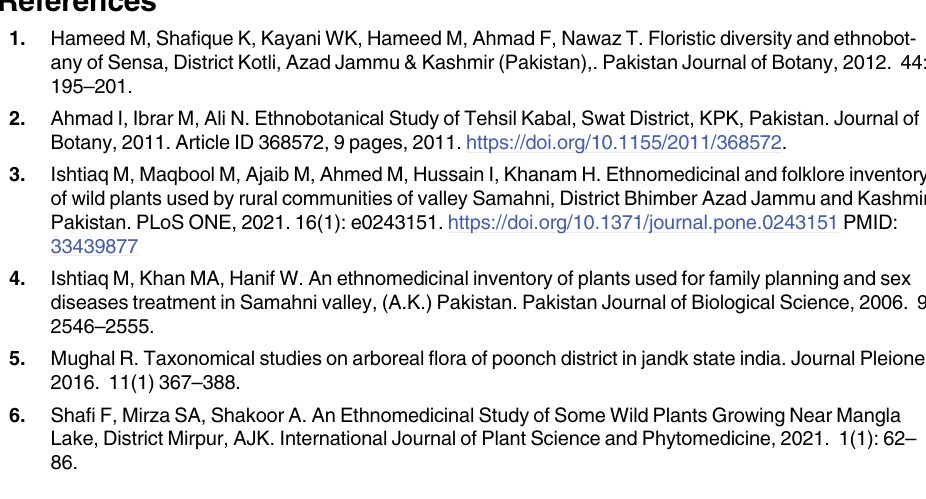
strict rules at governmental level to conserve of most common EB plant species from degrada- tion. There is need to expand the Prime ministers ‘billion’s tree tsunami’ project by involve- ment of youth in its propagation, cultivation and protection. This will lead towards ‘green revolution’ and make the environment eco-friendly with least pollution impacts as well as timely raining for good agriculture products and crops.